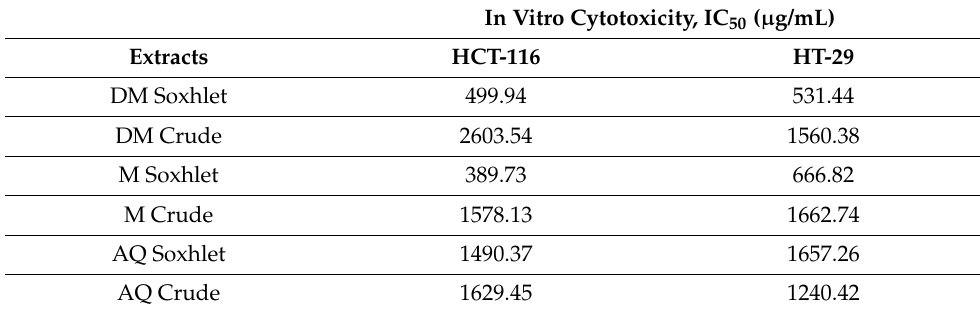
Figure 4. Effect of DM extracts on the viability of CRC cell lines. HCT-116 and HT-29 cells were seeded in 96-well plates and treated subsequently with different concentrations of DM extracts (0– 100–250–500–750 µg.mL −1 ). MTT tetrazolium reduction assay was used to measure HCT-116 and HT-29 cell viability after 24 h and 48 h treatment. ( A, B ) Effect of DM extract (Soxhlet and crude) on HCT-116 cells at 24 h and 48 h. ( C, D ) Effect of DM extract (Soxhlet and crude) on HT-29 at 24 h and 48 h. The percentage of cell viability was calculated considering the value of the control as 100%. Results are presented as the mean ± SD ( n ≥ 3). ** p < 0.01, *** p < 0.001, and **** p < 0.0001 vs. crude extract. #### p < 0.0001 vs. control group. DM: dichloromethane/methanol. Table 5. Cytotoxic activity of organic extracts on CRC cell